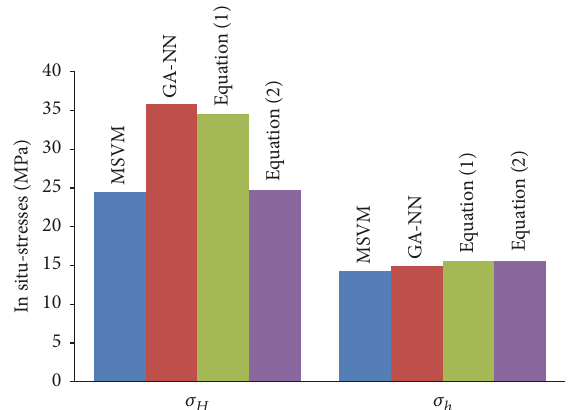
Figure 5: Comparison of recognized in situ stress using different models ( 𝜎 𝐻 , 𝜎 ℎ are the maximum and minimum in situ stress).